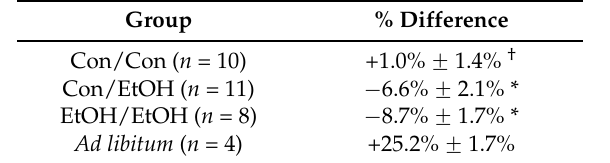
Table 3. Body Weight.